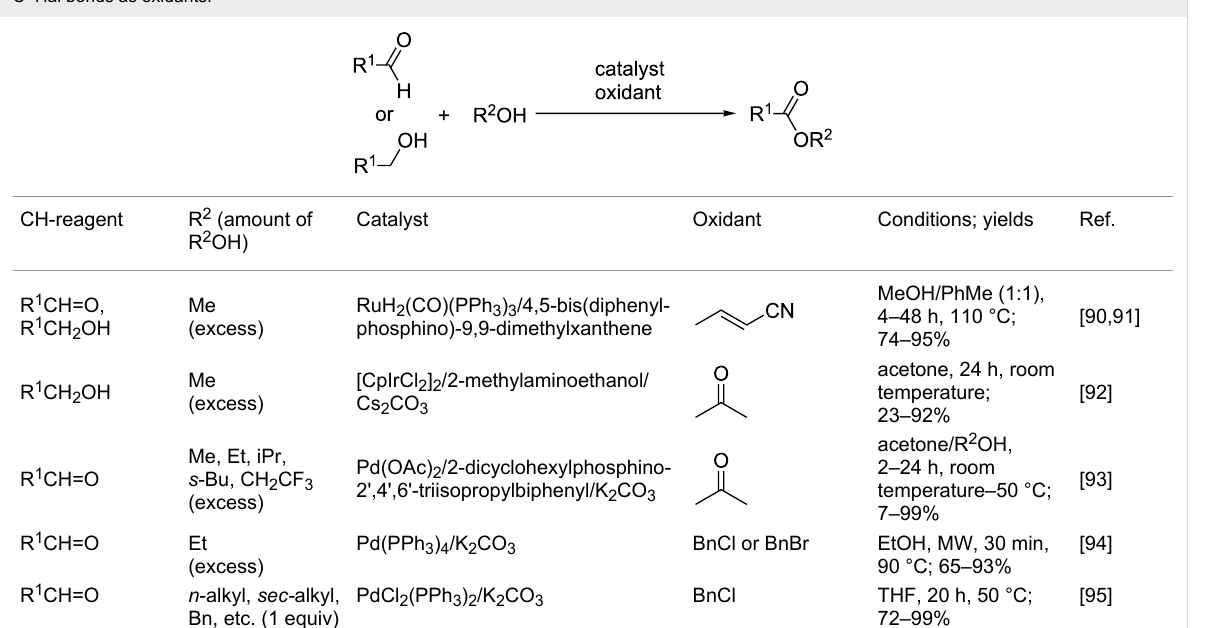
Table 2: Transition metal salt-catalyzed oxidative coupling of primary alcohols or aldehydes with alcohols using compounds with C=C, C=O, and C–Hal bonds as oxidants.